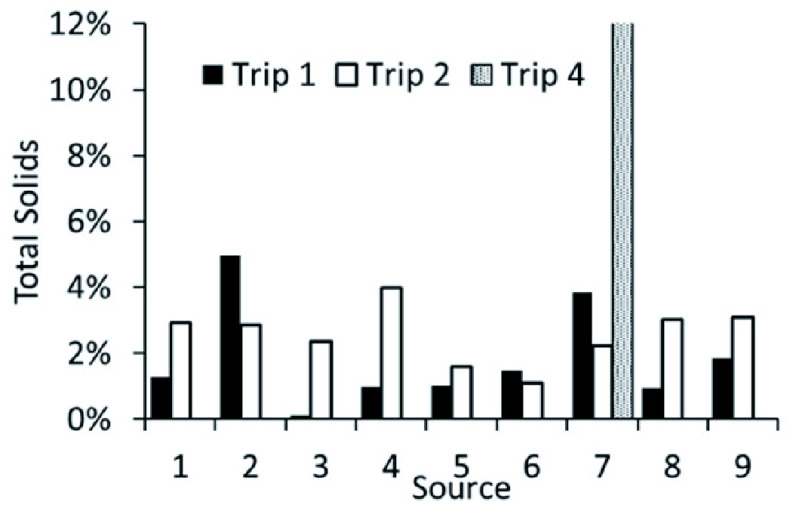
Multi-trip total solids (TS) results from Tiruppur.Source 7 required four consecutive trips, all other sources required two trips.